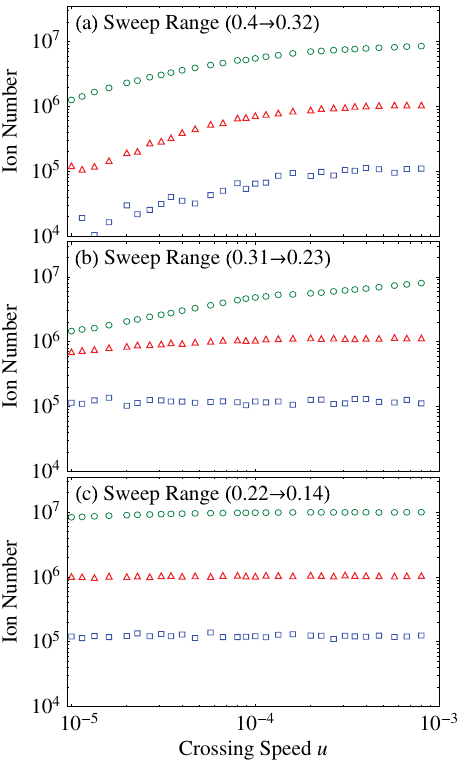
FIG. 12. Time evolution of the confined ion number at fixed tunes where either the second-order resonance (red) or the third- FIG. 11. Number of remaining ions after the LPT operating order resonance (blue) is activated. The operating tunes are point crosses a particular resonance at different speeds. The different in the upper and lower cases because of the density ranges of the bare-tune sweep are chosen as follows: dependence of the tune shift (see Fig. 8). The black line in each Þ ¼ ð 0 : 4 ; 0 : 32 Þ , (0.31, 0.23), and (0.22, 0.14). ð initial (cid:5) 0 ; final (cid:5) 0 panel is obtained at a resonance-free tune ( (cid:5) 0 ¼ 0 : 31 ). The Following the experiments in Fig. 8, we have taken three differ- initial numbers of Ar þ ions in the LPT are (a) 10 6 and (b) 10 7 . ent initial densities into consideration, namely, N in ¼ 10 5 (blue square), 10 6 (red triangle), and 10 7 (green